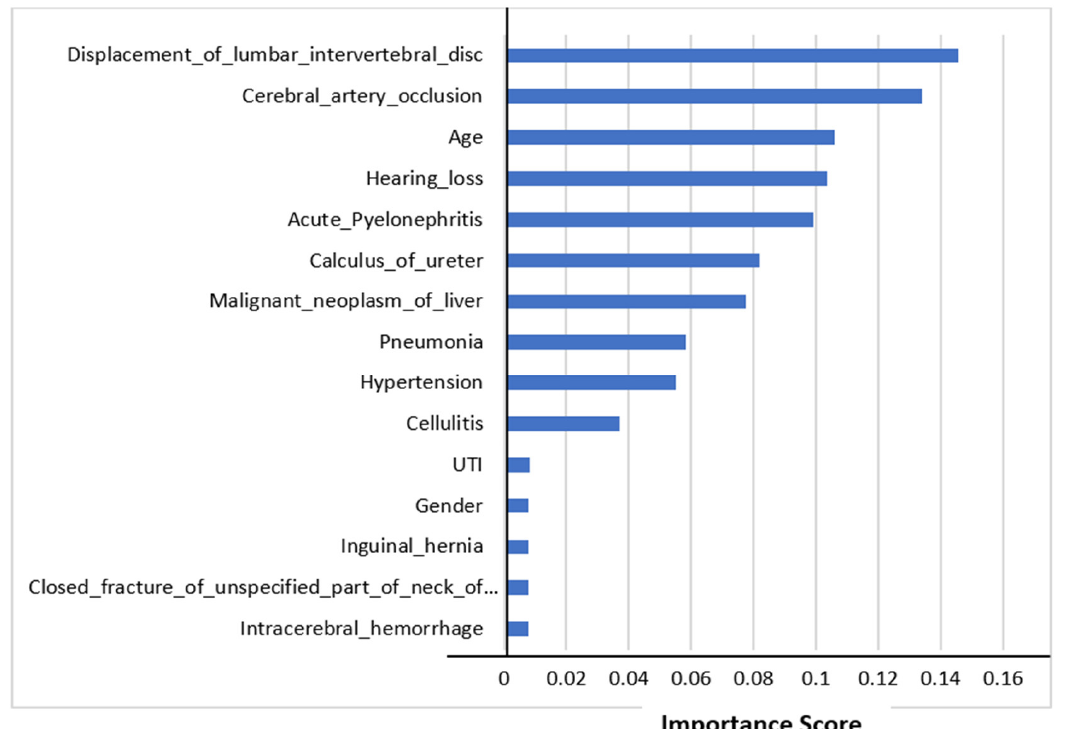
Figure 4. Feature importance scores in mortality prediction.